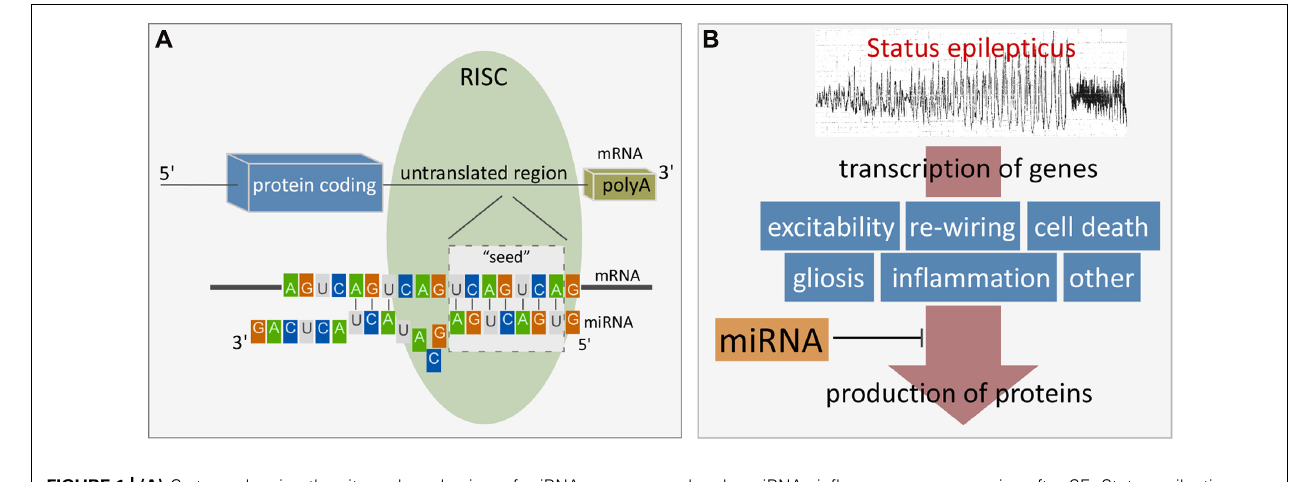
whereby miRNAs influence gene expression after SE. Status epilepticus results in transcriptional up-regulation of 100s of genes. miRNAs lie downstream of this and exert influence over protein production and as a result, influence post-injury outcomes such as repair, cell death and reorganization. Such miRNAs represent potential treatment targets to interrupt pathogenesis of damage and long-term consequences (e.g.,